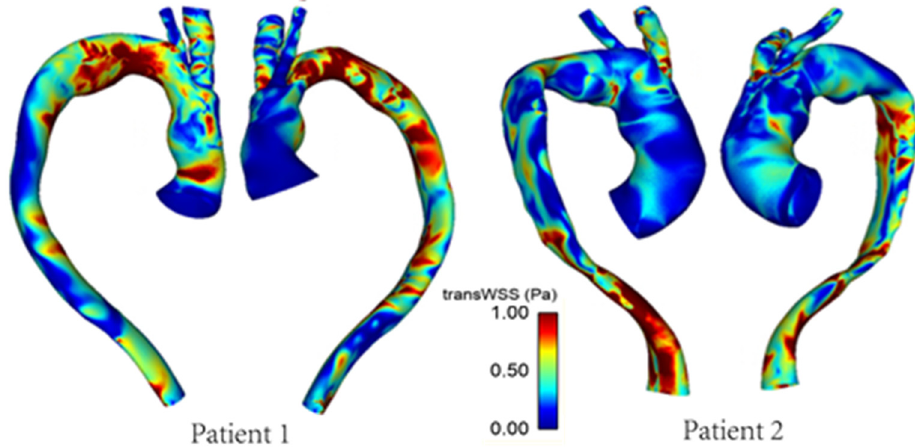
Figure 8. TransWSS distribution in the repaired aortas of Patients 1 and Figure 8. transWSS distribution in the repaired aortas of Patients 1 and 2.